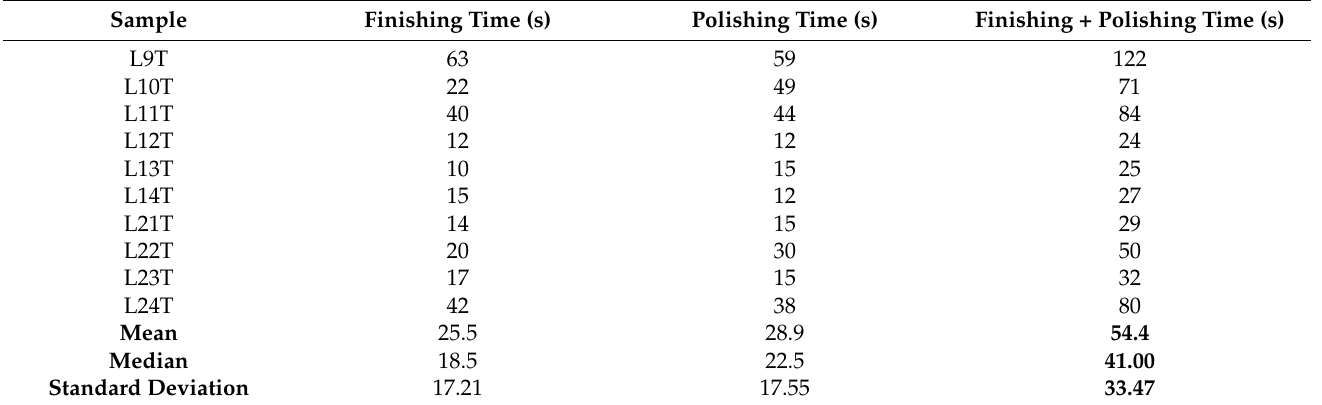
Table 11. Finishing time data in the study group.